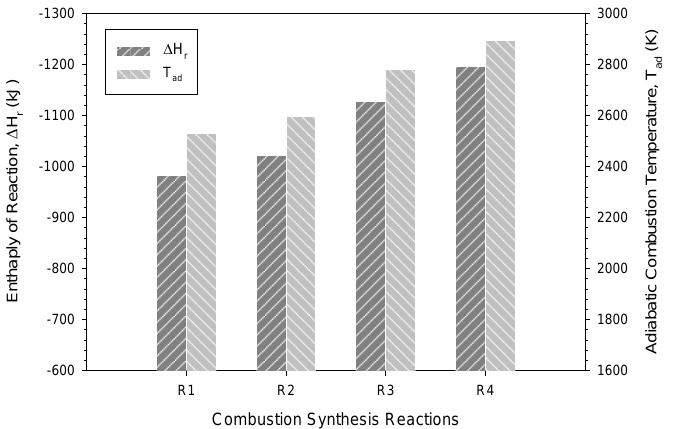
Figure 1. Enthalpies of reaction ( ∆ H r ) and adiabatic combustion temperatures ( T ad ) of Equation (1), Equation (2), Equation (3), and Equation (4) for the synthesis of 3TiB 2 – MgAl 2 O 4